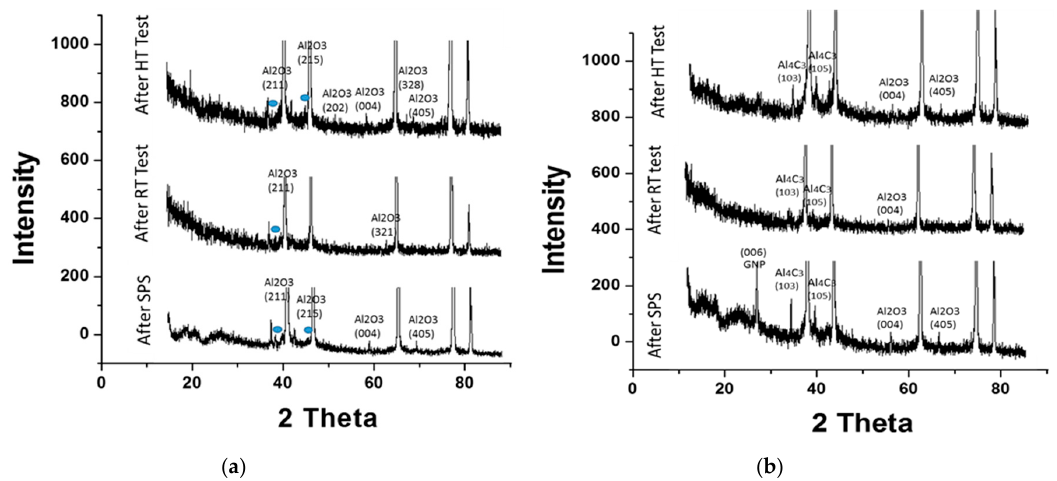
Figure 9. XRD after SPS, RT Test and HT Test for ( a ) Pure Al, ( b ) Al-2 vol % GNP.